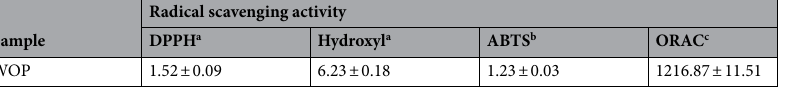
Table 2. Antioxidant activities of WOP using four types of assay systems. a EC 50 value (mg/mL), defined as the